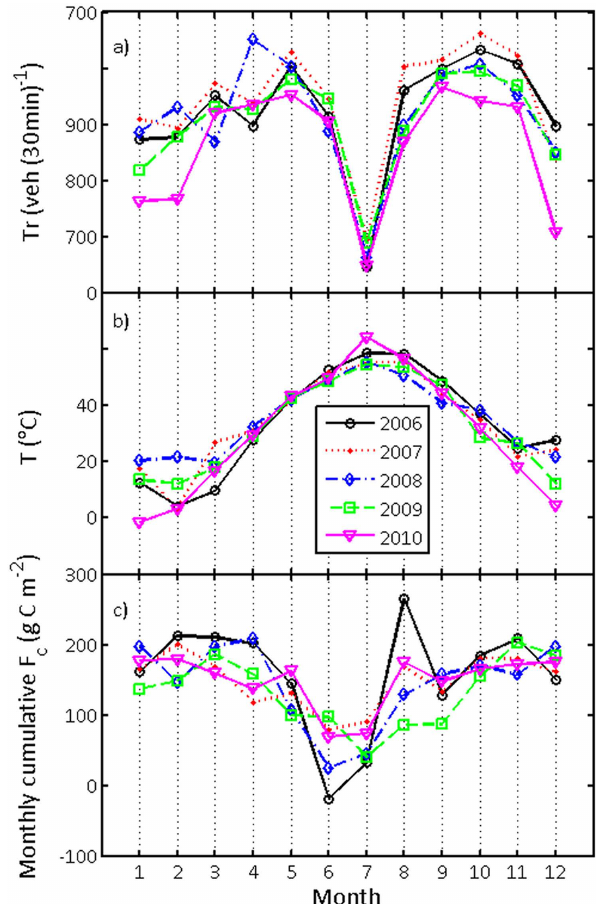
Fig. 3. Monthly mean (a) traffic rates and (b) air temperature, and (c) the monthly cumulative carbon flux separately for the studied